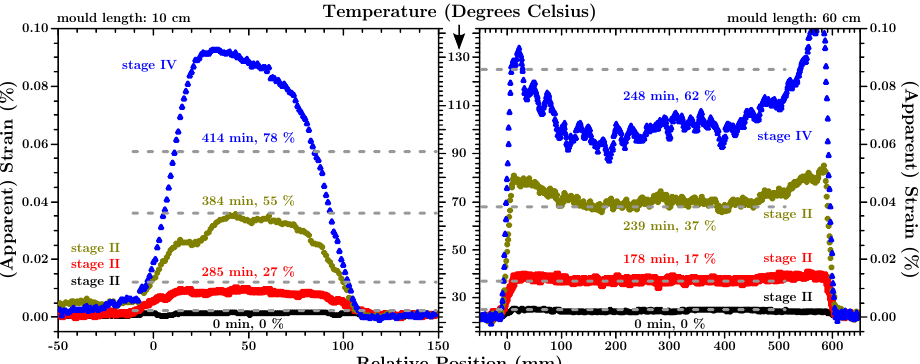
Figure 4. Development of the (apparent) strain values during Stage II and IV of the curing process over the whole length of 10cm (left graph) and 60 cm long molds for different times after the experiment was started. The values can be interpreted as both (apparent) strain and temperature (see text). Grey broken lines mark the average core temperature of the epoxy at the given time (see text).